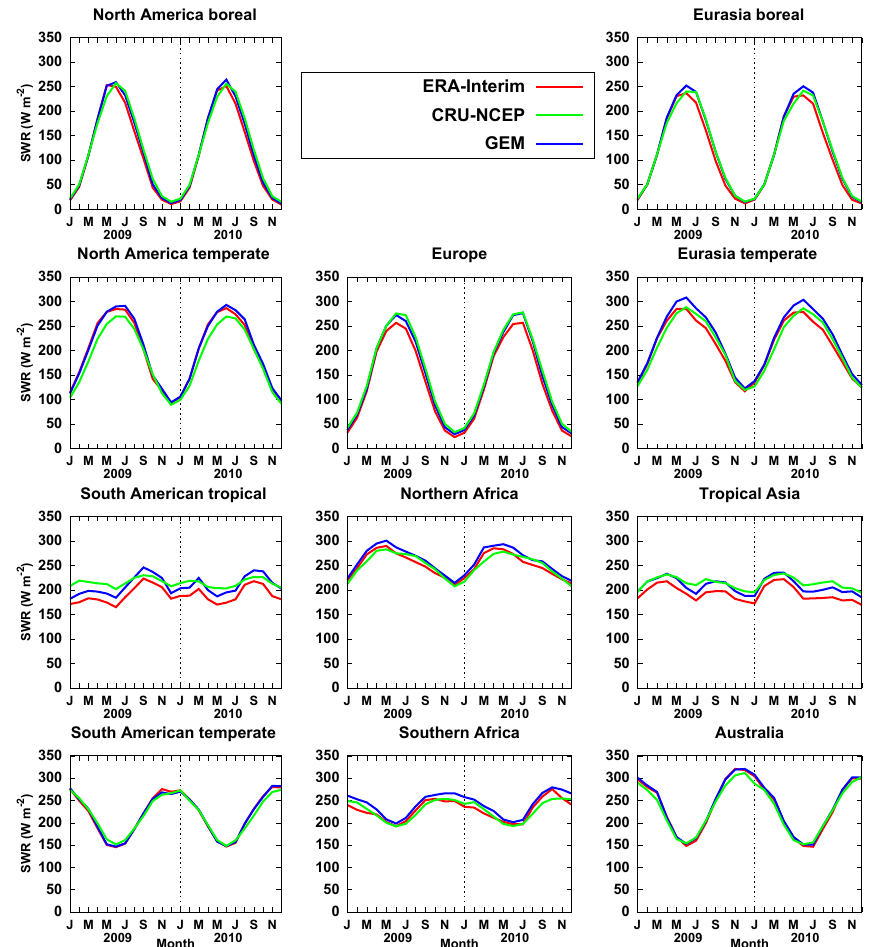
Figure 4. Monthly mean shortwave radiation (Wm − 2 ) averaged for the 11 TransCom land regions.